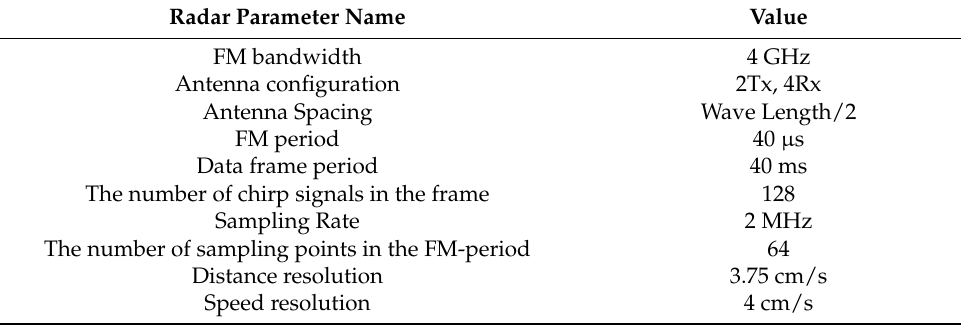
Table 1. Radar target detection parameter setting.